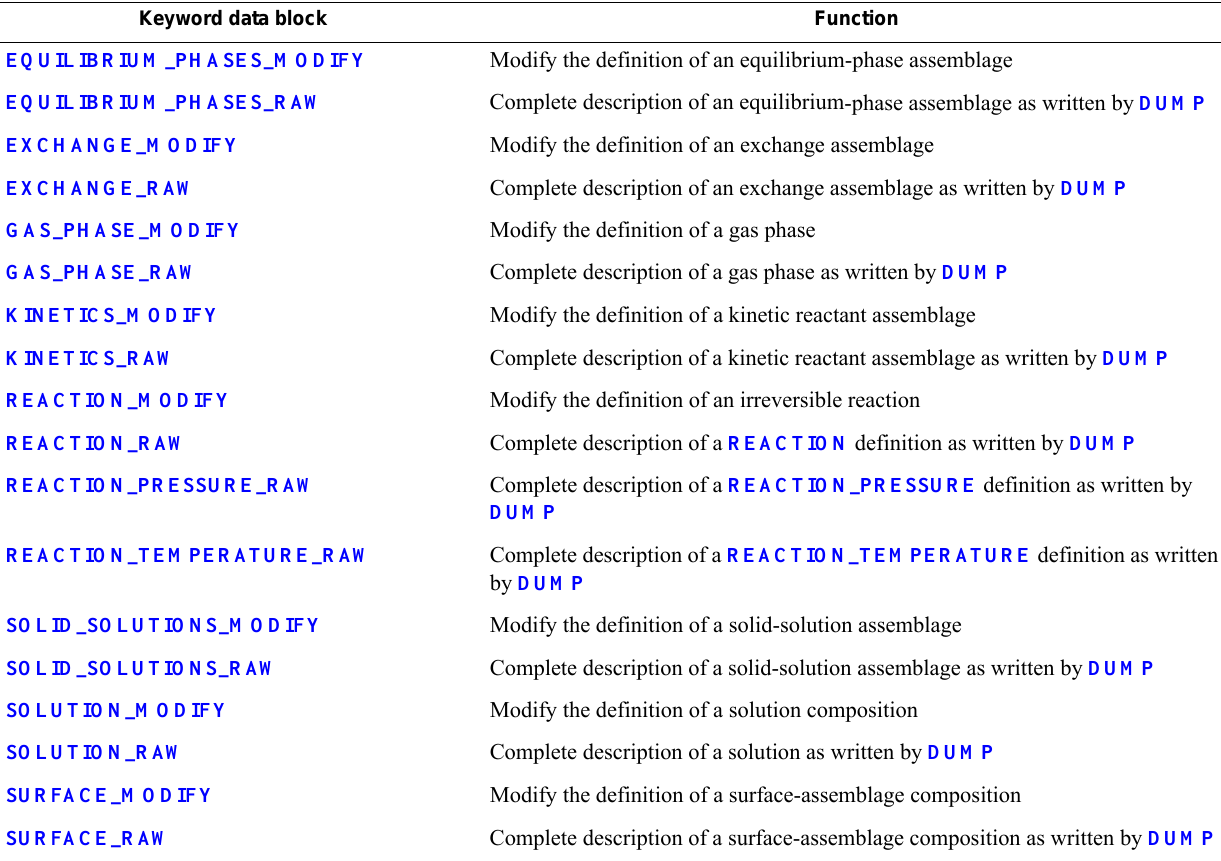
Table A1. List of keyword data blocks for scripting and